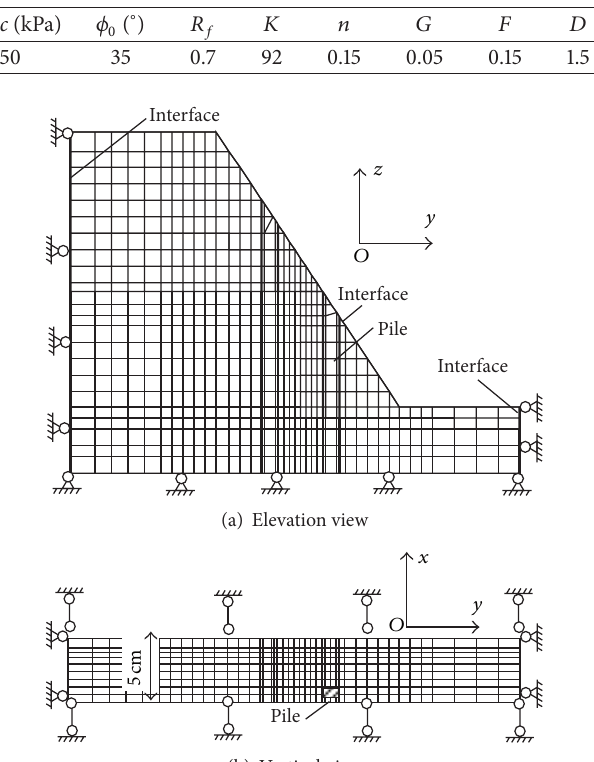
Table 1: Model parameters of the elastoplasticity model for soil.